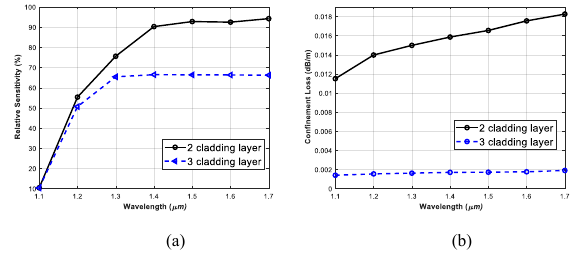
FIGURE 8. Variation of the relative sensitivity with the refractive index of